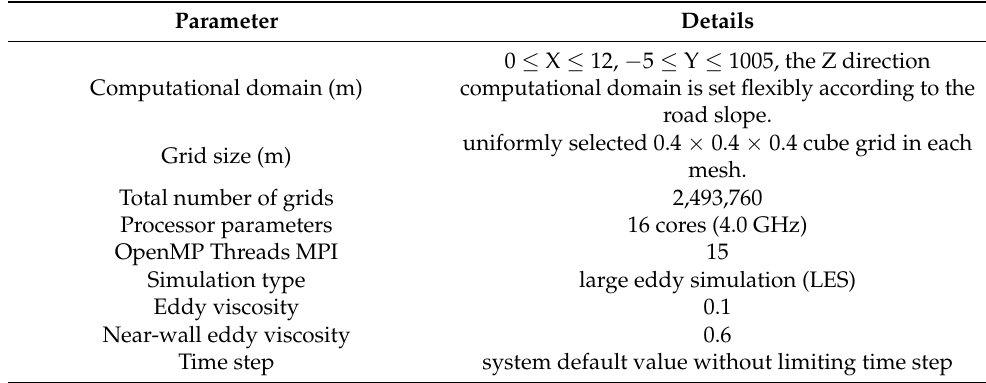
Table 5. Grid and simulation